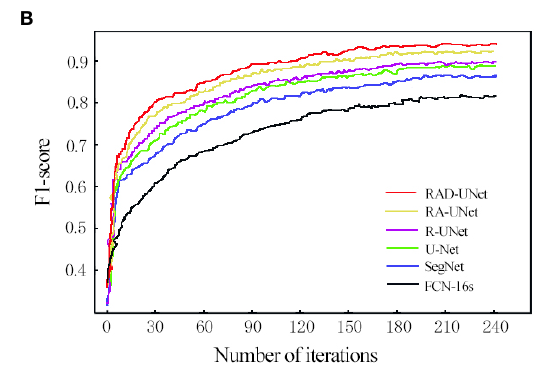
FIGURE 10 (A) Segmentation results of different algorithms in terms of multiple